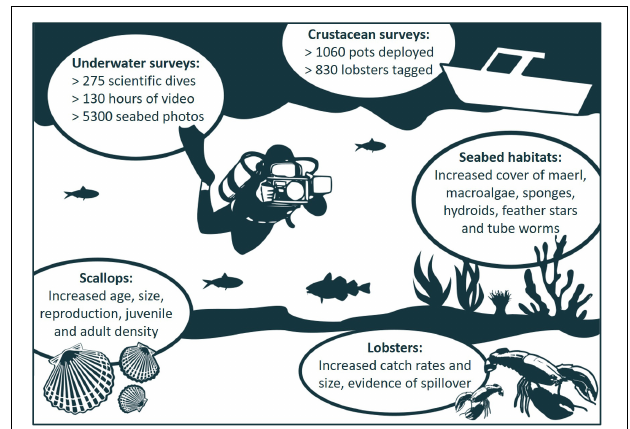
FIGURE 5 | Survey methods used in annual monitoring of Lamlash Bay NTZ where underwater surveys ran from 2010 to 2019 and crustacean surveys from 2012 to 2018. Also detailed is evidence of how protection has benefited seabed habitats and species of commercial interest. For full details,